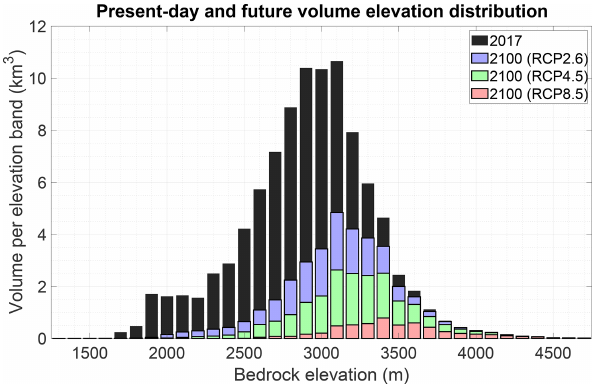
Figure 10. Modelled volume elevation distribution in 2017 and in 2100 under various representative concentration path- ways (RCPs). The values in 2100 correspond to the multi-model mean under a specific